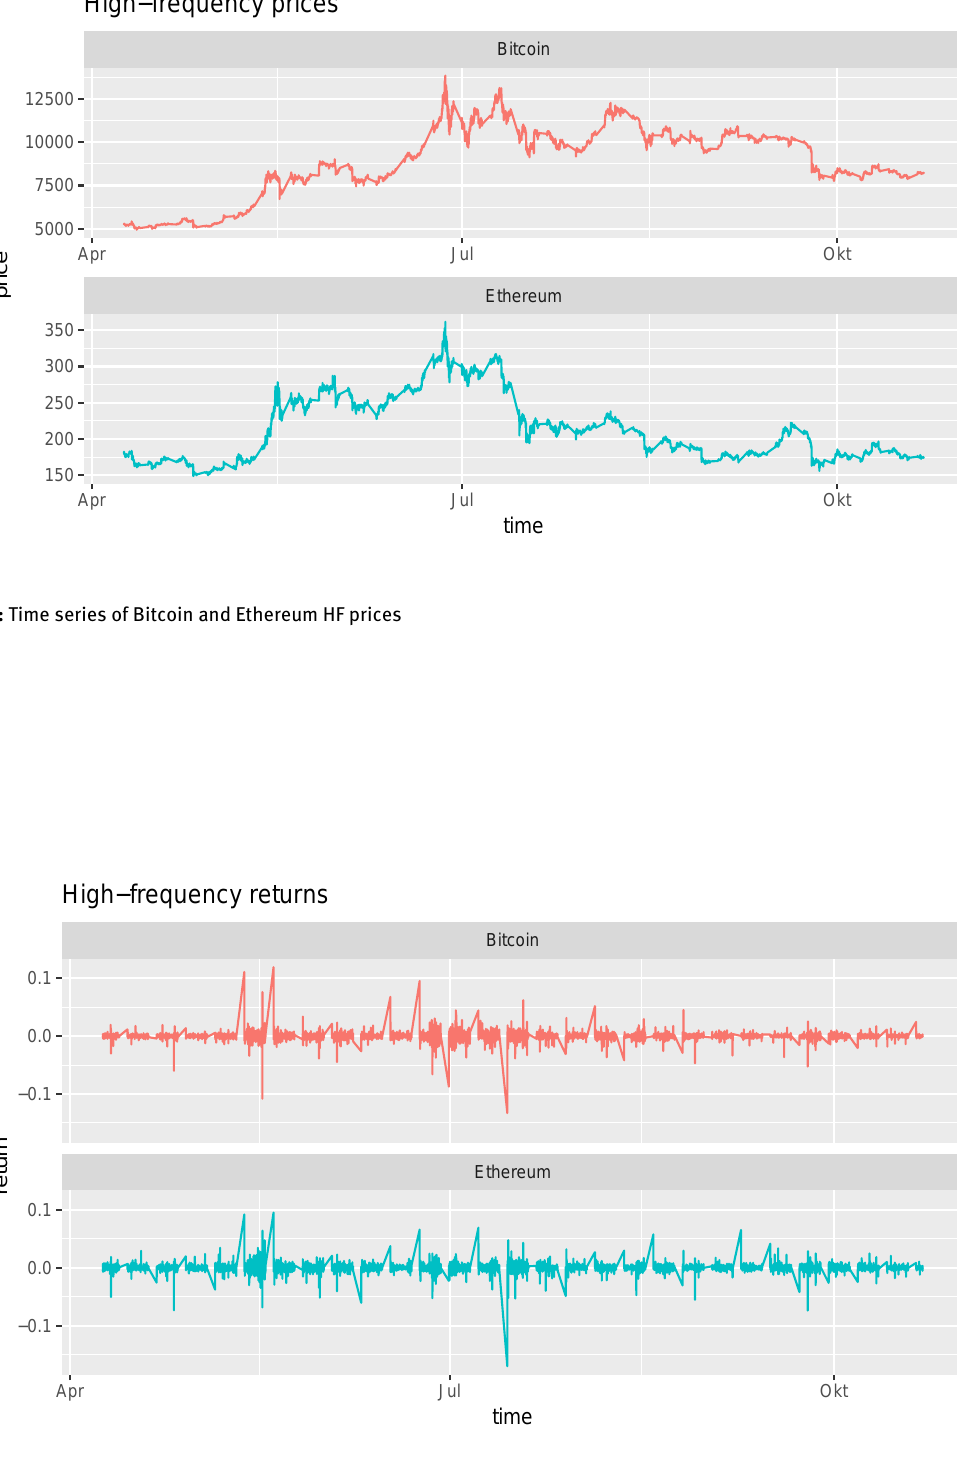
Figure 7: Time series of Bitcoin and Ethereum HF